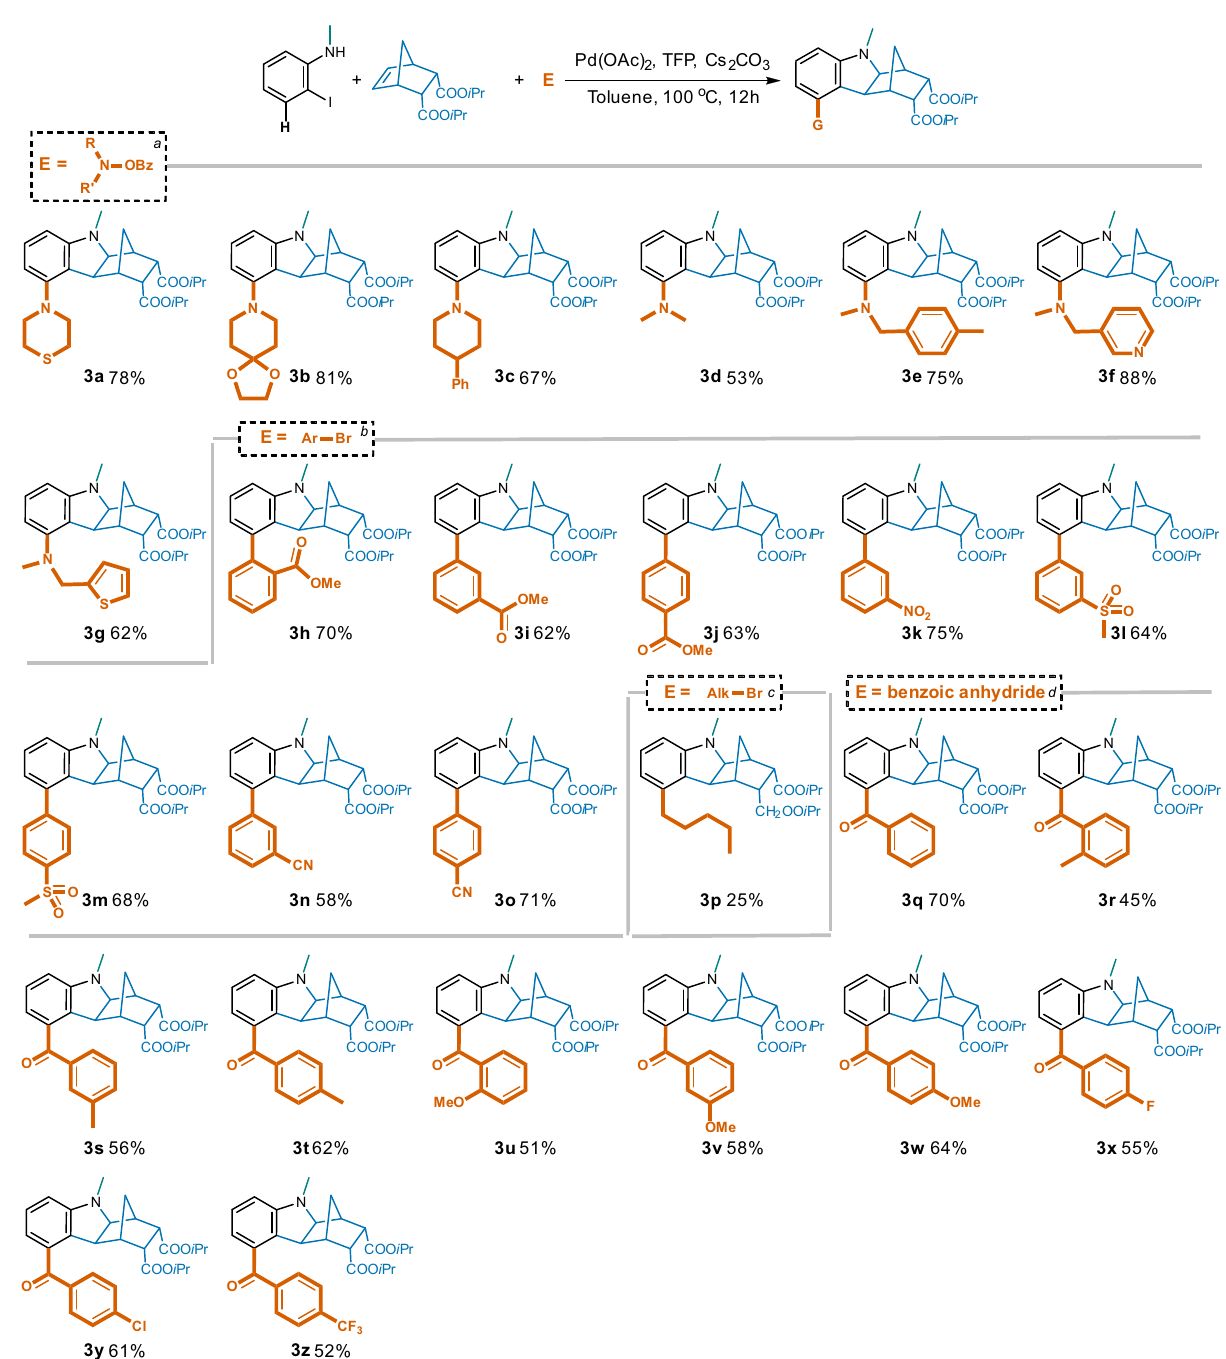
Fig. 5 Generation of 5-substituted hexahydro-1 H -1,4-methanocarbazoles with various electrophiles. Reaction conditions: [a] 2-iodo- N -methylaniline (1.0 eq.), NBE-5,6-diCOO i Pr (1.0 eq.), N -benzoyloxyamine (1.3 eq.), Pd(OAc) 2 (5% eq.), TFP (10% eq.), Cs 2 CO 3 (2.5 eq.), toluene, 100 o C, 12 h; [b] arylbromide (1.3 eq.), and DMF were used instead; [c] n- pentylbromide (1.3 eq.), PPh 3 (10% eq.), and DMF were used instead; [d] benzoic anhydride (1.3 eq.), PdCl 2 (5% eq.), and DME were used